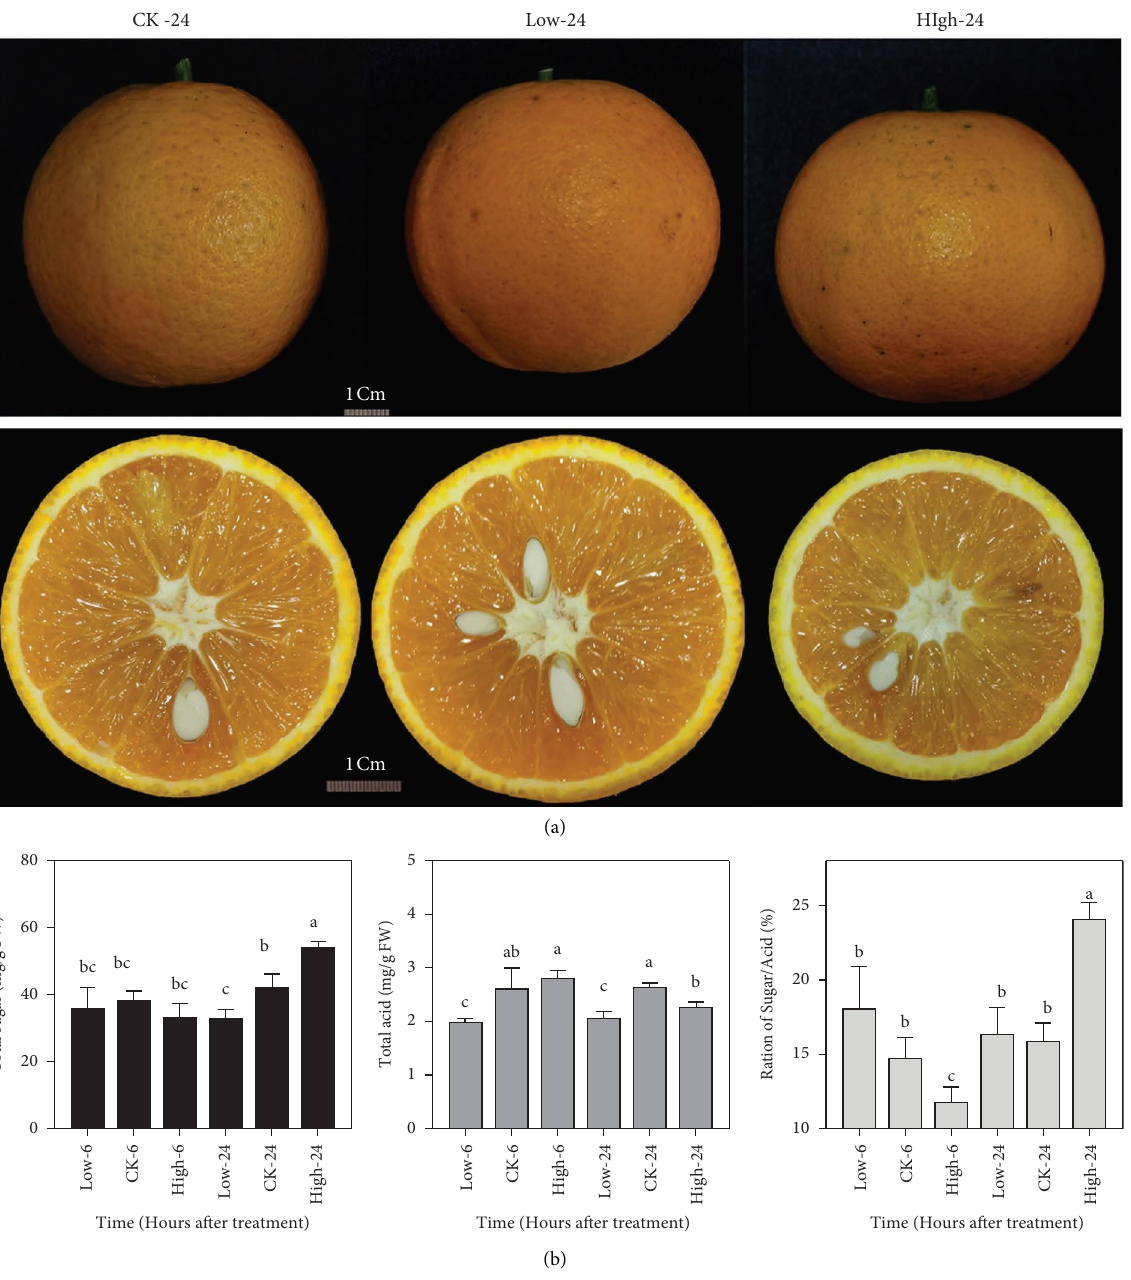
Figure 1: Content of total sugar and organic acid in the pulp of Valencia orange fruit. Te vertical bars represent the standard errors of the mean. (a) Te appearance of fruits with diferent treatments. (b) Content of total sugar, total organic acid, and the ratio of sugar to acid under diferent treatments. Te vertical bars represent the standard errors of the mean. Values with diferent letters within the same fgure are signifcantly diferent according to the ANOVA test at p < 0 .